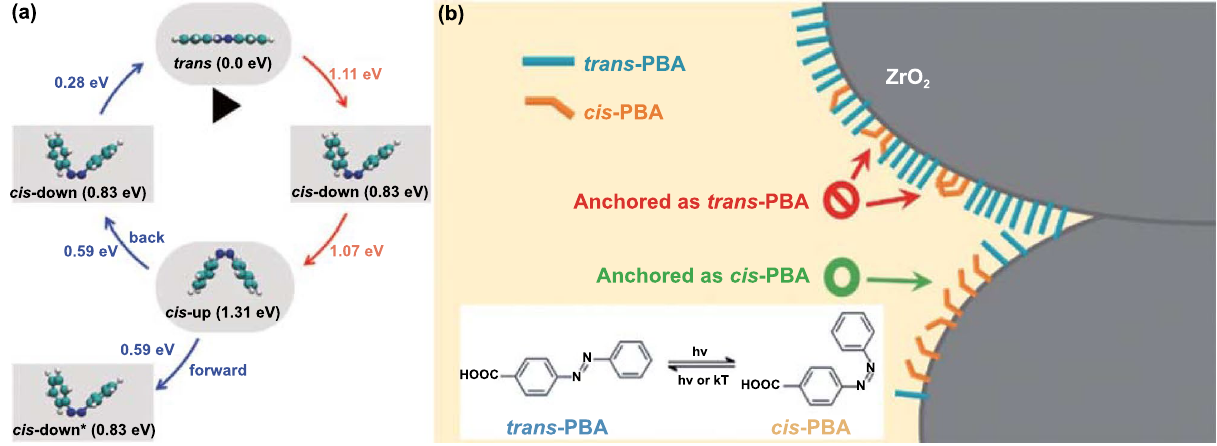
Fig. 17 a Catalytic mechanism of AuNPs [150]. b Catalytic mechanism of ZrO 2 nanoparticle films